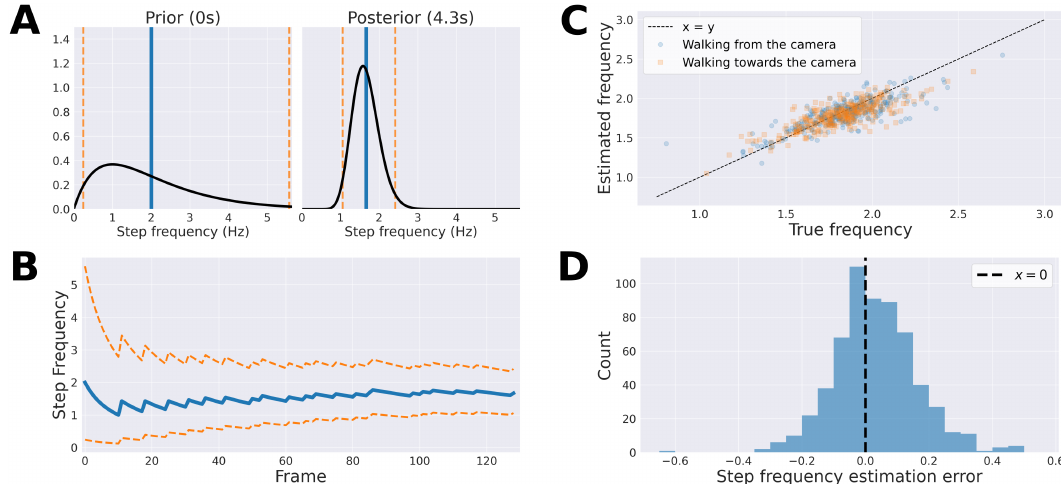
Figure 4. Bayesian step frequency estimation. ( A ) Examples of the prior distribution (left) and a posterior distribution after 129 updates (i.e., after 129 frames or approximately 4.3 s of video); ( B ) the evolution of the posterior mean and 95% credible interval for the first 129 updates; ( C ) point estimates of the Bayesian step frequency model’s posterior distributions at the last frame of each video were highly correlated with the true labels (Pearson’s r = 0.80, p < 0.001). The mean squared error between estimated and true step frequency was 0.018 Hz; ( D ) the distribution of errors of step frequency point estimates in the last frame of each video. The mean error was 0.03 Hz, indicating a tendency to under-predict. The null-hypothesis that the population is normally distributed was rejected (Shapiro Wilk’s W = 0.98, p <